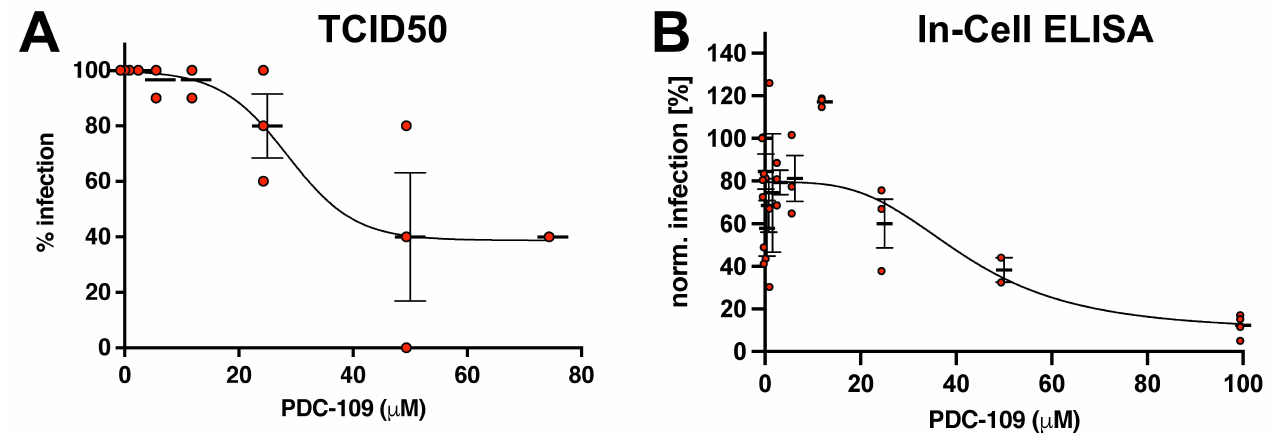
Figure 4. PDC-109 effects on live CoV-2 infection in cell culture. The antiviral activity of PDC was assessed by TCID50 assay or In-Cell ELISA. ( A ) VeroE6 cells were pre-treated with different concentrations of PDC in 10 repeats for 15 min and incubated with infectious CoV-2 (Essen isolate) for 2 h at 37 ◦ C. Subsequently, PDC-containing media were replaced with fresh media, and cells were incubated for another 3 to 5 days to allow for spreading infections in the cell culture. Trypan blue staining was conducted to determine viral cytopathic effects. The frequency of wells with intact cell monolayers per PDC concentration was utilized as a measure of viral infectivity. Each point represents the data of one independent experiment. Solid lines show inhibitor-response curves generated using four-parameter fits. ( B ) VeroE6 cells were pre-treated with different concentrations of PDC and incubated with infectious CoV-2 (Essen isolate) for 2 h at 37 ◦ C, followed by media exchange and incubation at 37 ◦ C. In-Cell ELISA was performed 24 h post-infection. Dots show the mean of three technical repeats per condition from 2–3 independent experiments. Thick lines show arithmetic mean with SEM. B shows data normalized to mock-treated infection controls. IC50 values can be found in SI Table